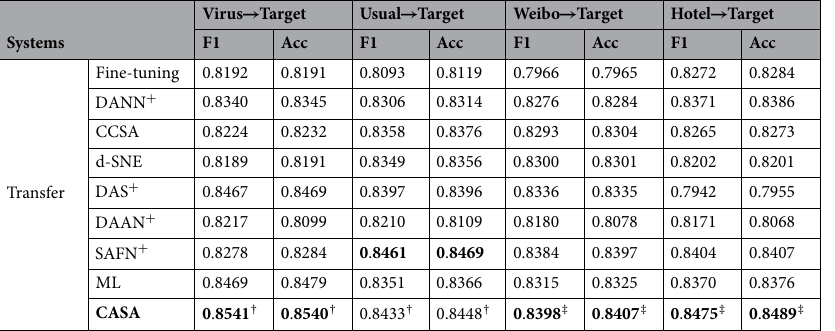
Table 3. Model comparison results with domain adaptation. The state-of-the-art result of each dataset is bolded. The marker † refers to p-value < 0.05 by comparing with ML in paired t-test, while the marker ‡ refers to p-value < 0.05 by comparing with SAFN + in paired t-test. All models run over five times with random initializations and report the mean results.